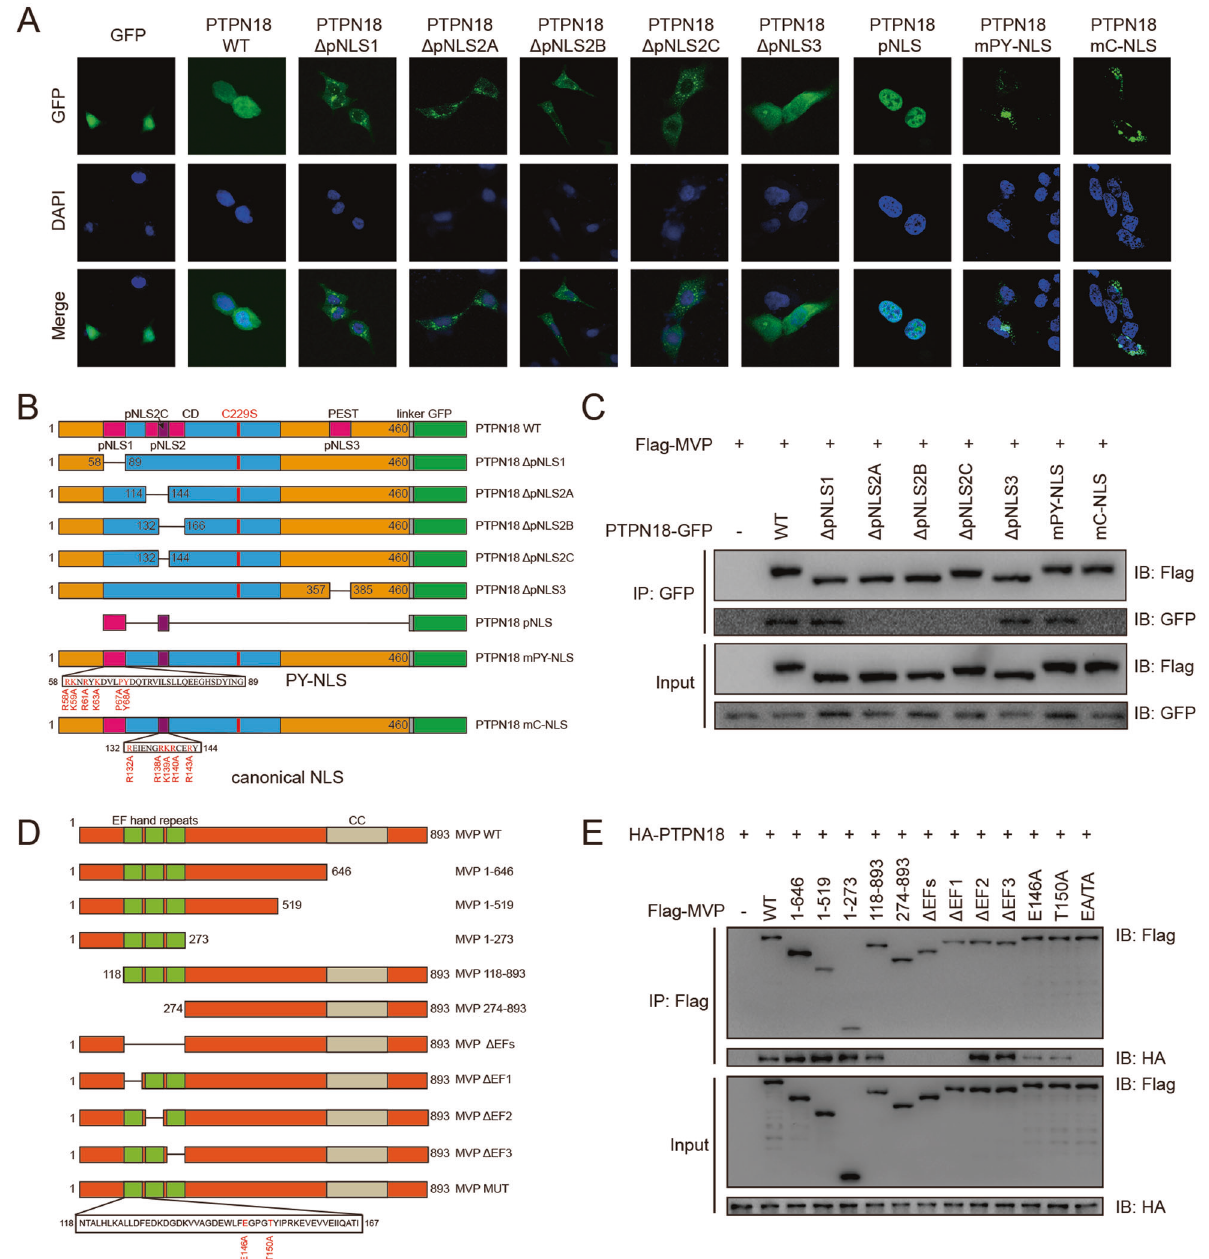
Fig. 2 Investigation of crucial regions and residues mediating the PTPN18-MVP interaction. A Subcellular localization of different PTPN18- GFP truncations in MCF7 cells. B Schematic representation of different PTPN18 truncations based on their putative NLS domains. C Co-IP of Flag-MVP with different truncated forms of PTPN18-GFP in 293 T cells. D Schematic representation of different MVP truncations based on their functional domains. E Co-IP of HA-PTPN18 with different truncated forms of Flag-MVP in 293 T